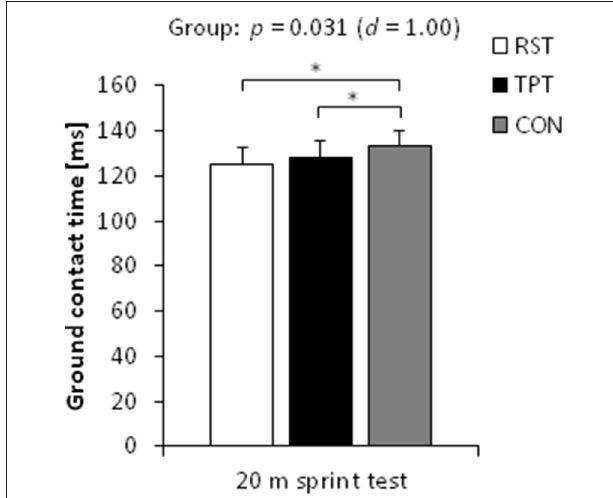
FIGURE 4 | Baseline-adjusted post-test means and standard deviations of ground contact time during the 20m linear sprint in the resisted sprint training (RST) group, traditional power training (TPT) group, and control (CON) group. * p <